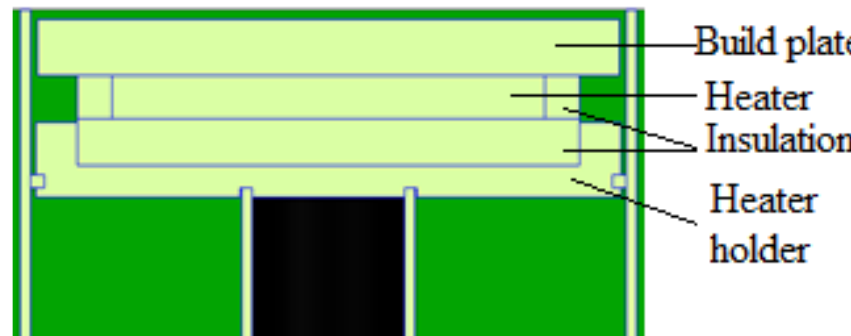
Figure 13. Side view of QuickPre concept.